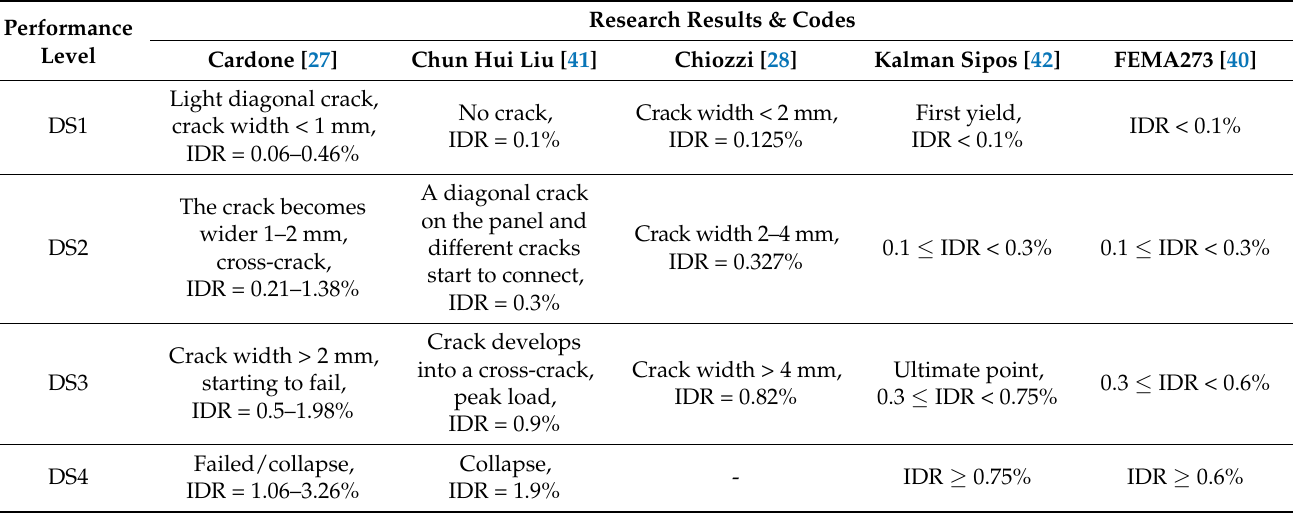
Table 1. The damage states the definition of infilled frame in some researchers and